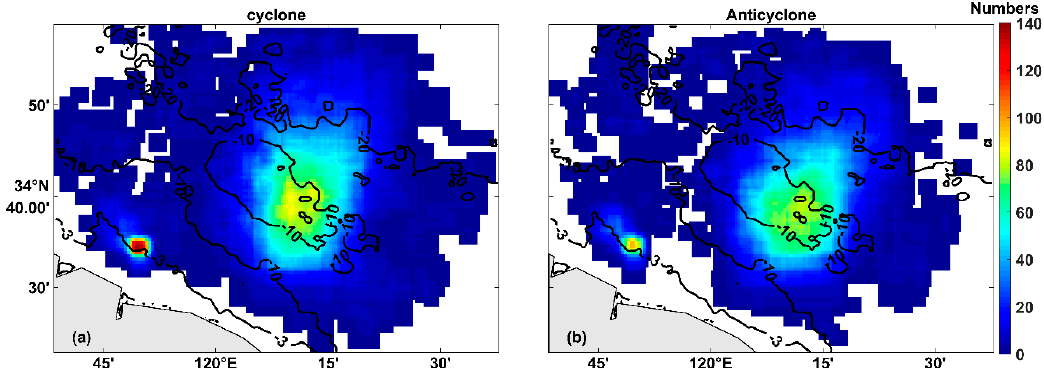
Figure 6. The total number of cyclonic ( a ) and anticyclonic ( b ) eddies derived by HFRs current fields based on the VG method during the observation period. The total number of eddies in each grid is increased if the eddy exists in the grid.